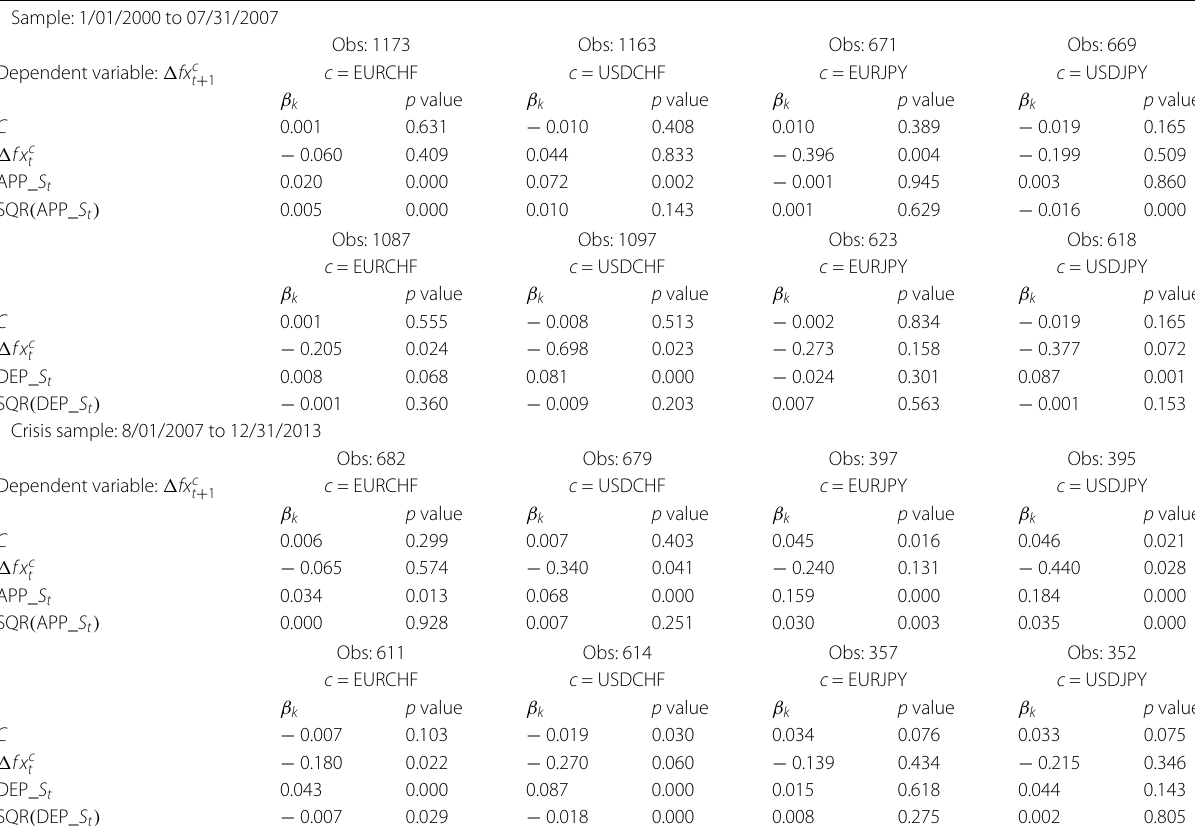
Table 6 Non-linearity Sample: 1/01/2000 to